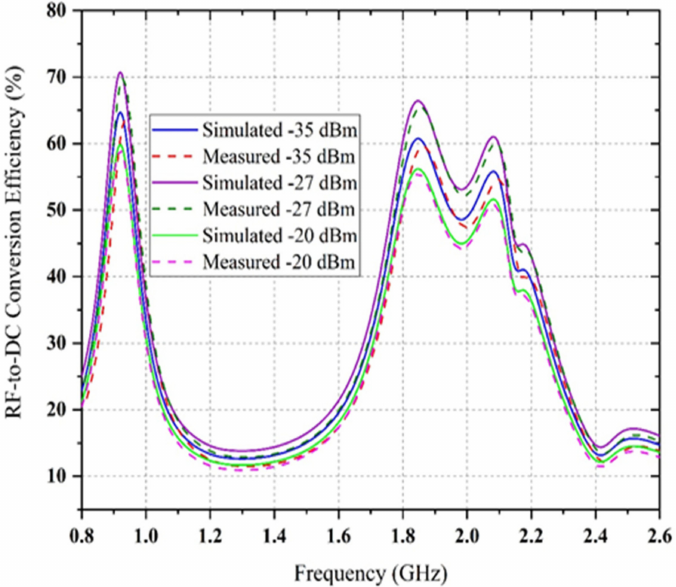
Figure 20. The comparison between simulated and measured DC rectification efficiency of the quad-band rectifier versus frequency at four RF input power levels and a constant load of 6.81 k Ω .